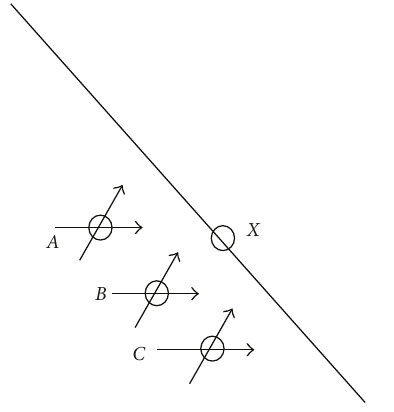
Figure 2: Disambiguating evidence for motion in multiple direc- tions (see